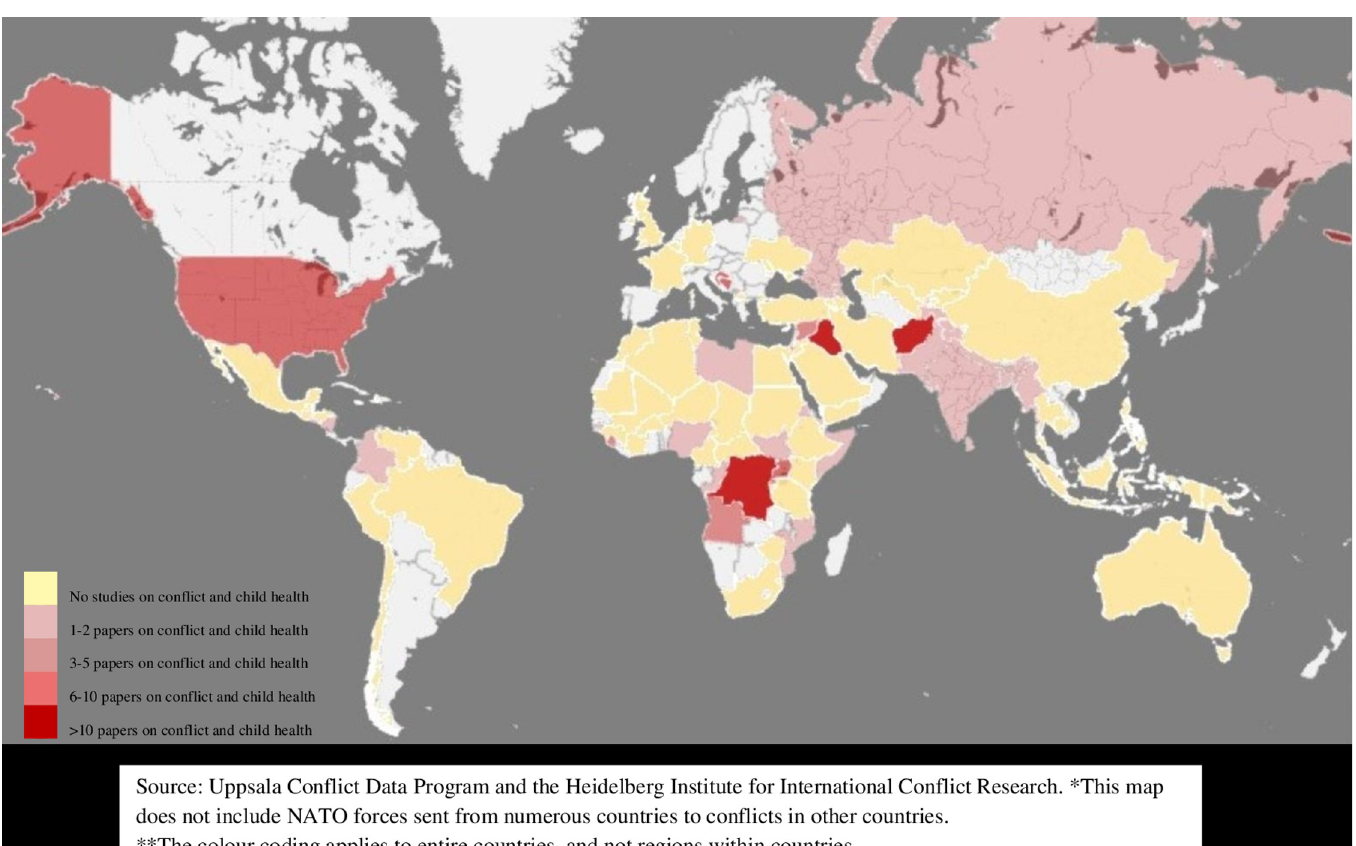
Fig 4. The number of published studies on child health in countries with documented armed conflict